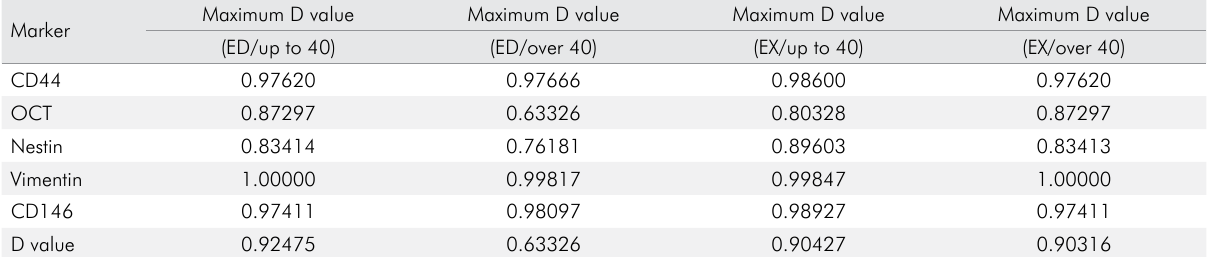
Table. Maximum desirability values for each marker (CD44, OCT, nestin, vimentin and CD146) and D values considering all markers for each situation (ED/up to 40, ED/over 40, EX/up to 40 and EX/over